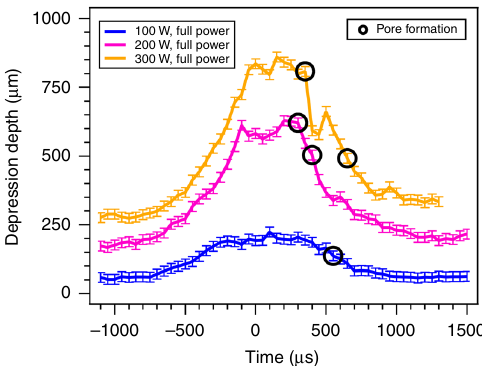
Fig. 4 Vapor depression depth as a function of time for various laser powers at a laser turn point with a programmed steady-state scan speed of 1000 mm s − 1 . These scans used a constant power, and time zero corresponds to the midpoint of the turn ( t mid-point = 0 µ s). The laser is at steady-state scan speed before it begins to decelerate at approximately − 900 µ s to initiate the turn. Minimum laser scan speed is reached at 0 µ s after which it immediately starts to accelerate, returning to steady-state scan speed at approximately 1200 µ s. The turn midpoint was determined by analysis of the in situ X-ray images. Black circles denote pore formation events. Error bars represent uncertainty in the distance between the base of the vapor depression and the surface caused by surface